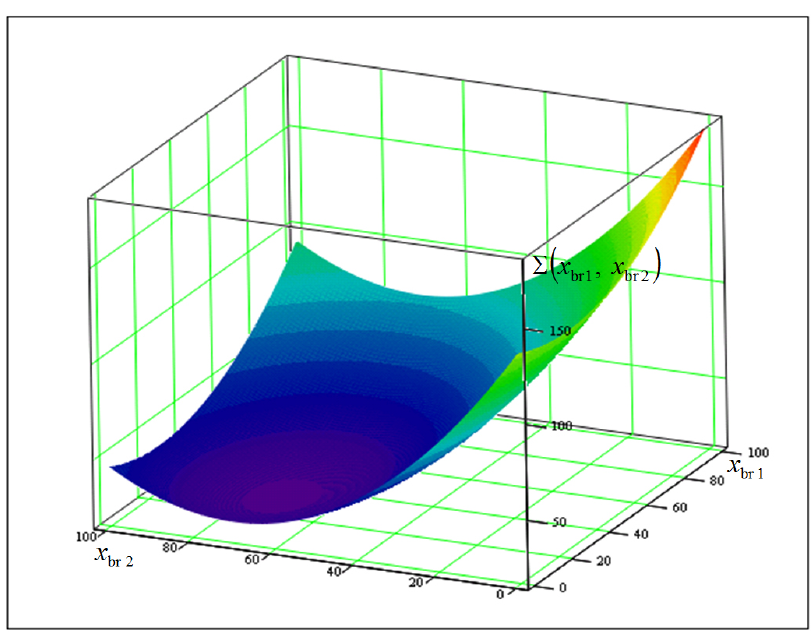
Figure 4. Simplified paraboloid (5) for presented example.